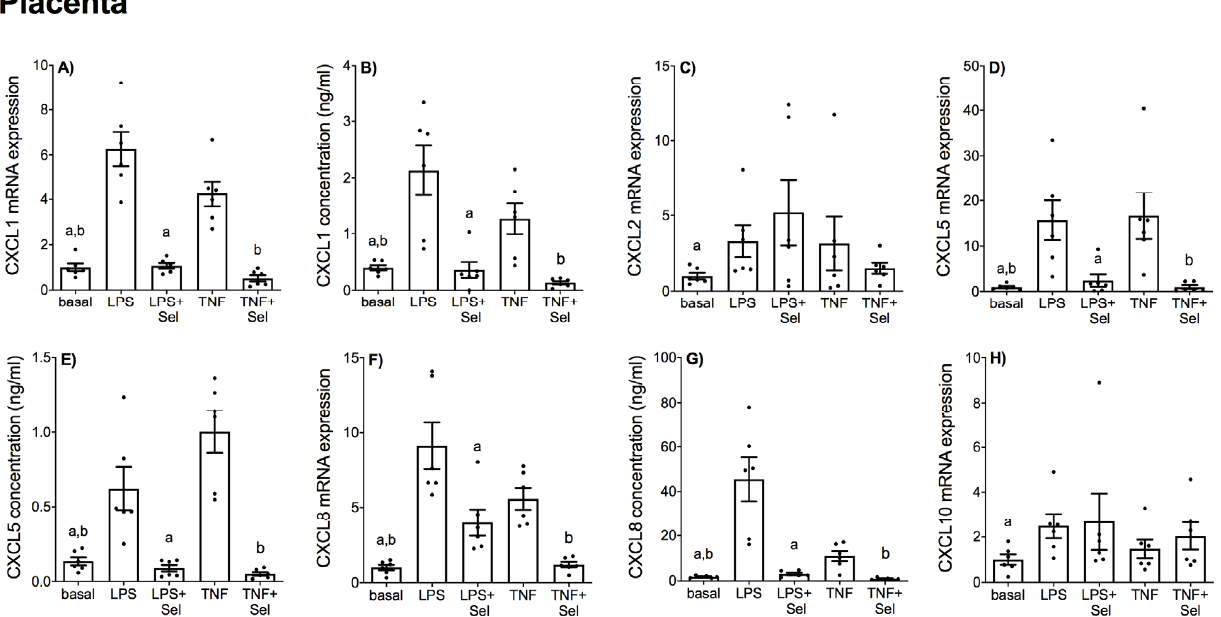
Figure 5. Effect of selenium on CXCL chemokine expression in human placenta. Placenta was incubated with or without 10 µ M sodium selenite (Sel) for 1 h and then stimulated with 10 µ g/mL LPS or 10 ng/mL TNF- α for a further 20 h ( n = 6 patients). ( A , C , D , F , H ) CXCL1, CXCL2, CXCL5, CXCL8 and CXCL10 mRNA expression was analysed by RT-qPCR and fold change was calculated relative to basal expression. ( B , E , G ) The concentration of CXCL1, CXCL5 and CXCL8 in the conditioned media was assayed by ELISA. For all graphs, individual data points represent six independent experiments and are displayed as mean ± SEM. a p ≤ 0.05 vs. LPS, b p ≤ 0.05 vs. TNF; repeated measures one-way ANOVA.